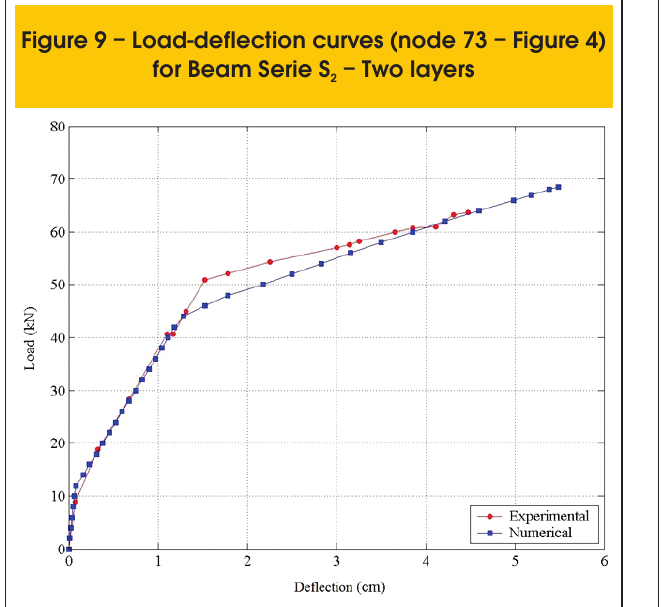
Figure 11 – Load-deflection curves (node 73 – Figure 4) for Beam Serie S – Three layers